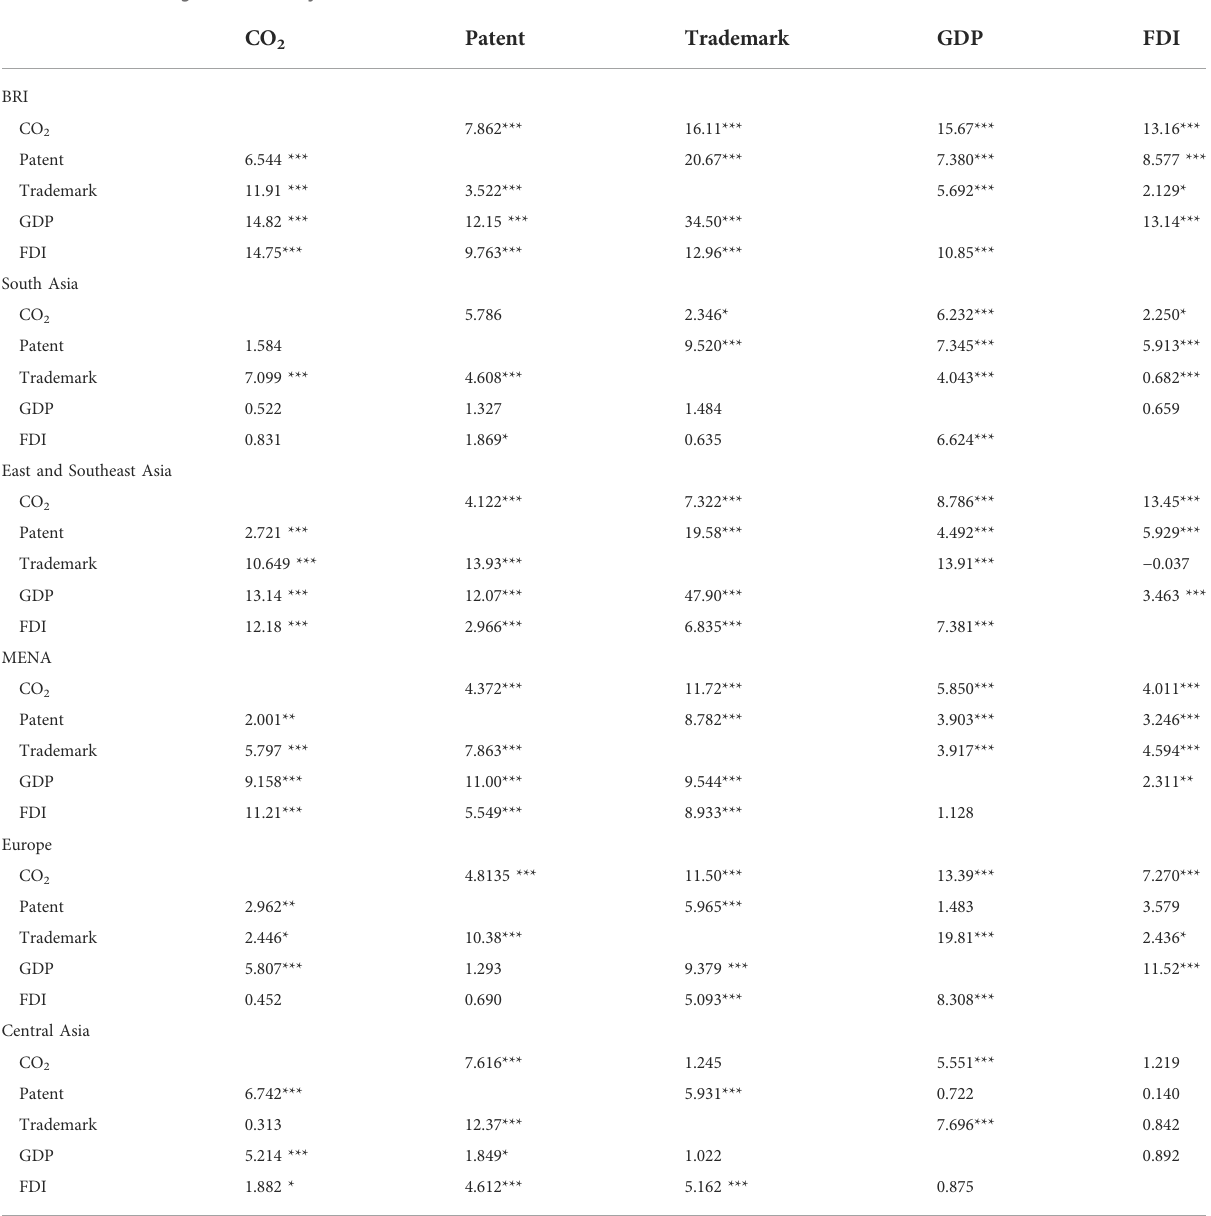
TABLE 8 Panel heterogenous causality results.